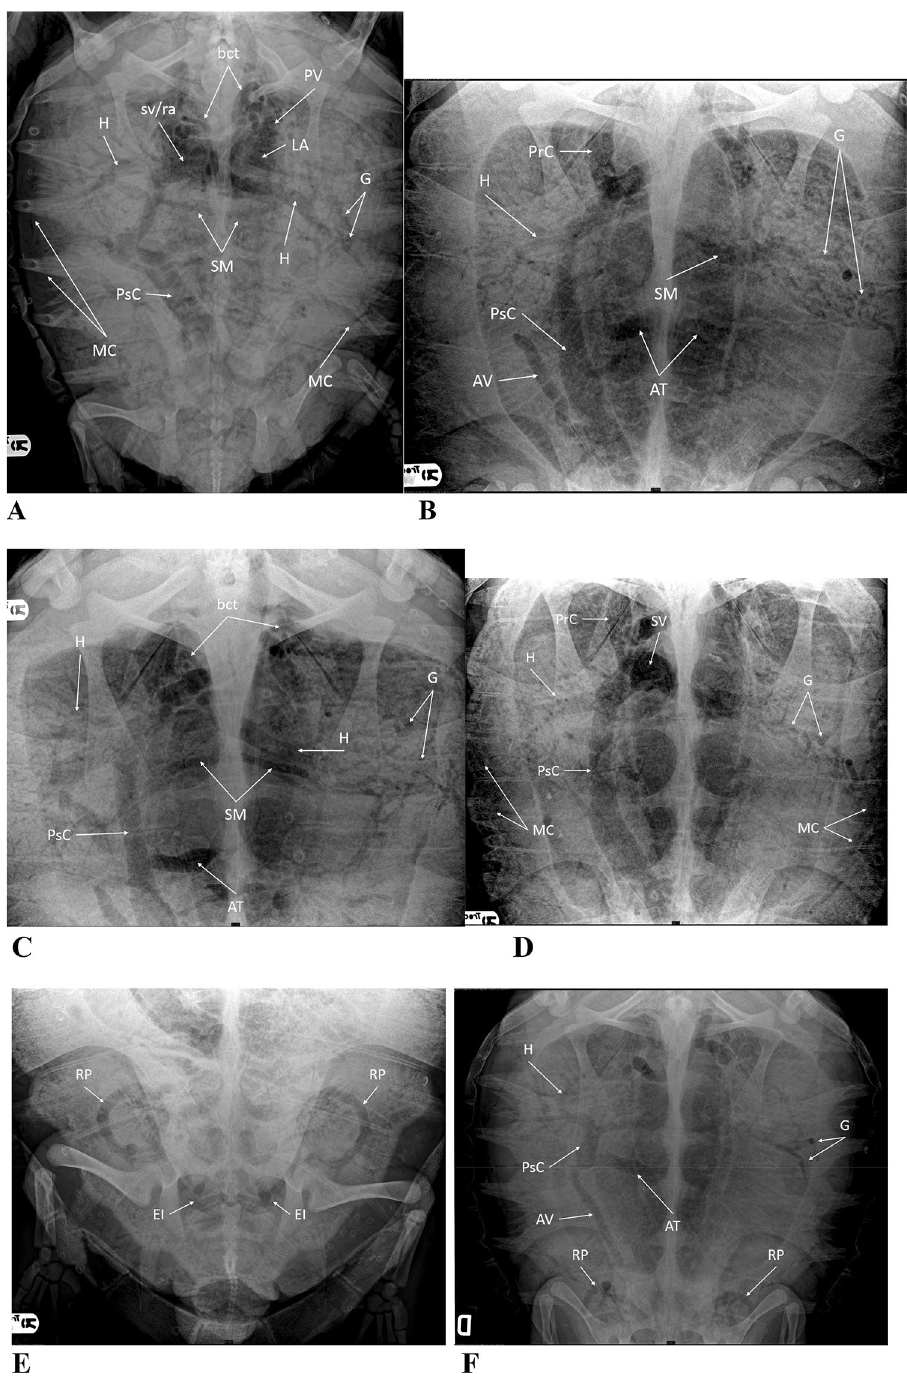
Figure 5. ( A ) Dorsoventral radiograph of a Loggerhead turtle ( Caretta caretta ) with severe GE. Gas is evident in the sinus venosus/right atrium (sv/ra), left atrium (LA), pulmonary vessels (PV), vessels of the brachiocephalic trunk (bct), hepatic vessels (H), gastric vessels (G), postcava vein (PsC), superior mesenteric artery (SM) and marginocostal vessels (MC); ( B,C ) dorsoventral radiograph of two Loggerhead turtles ( Caretta caretta ) with GE of medium to severe degree. Precava (PrC) and postcava vein (PsC), vessels of the brachiocephalic trunk (bct), hepatic vessels (H), gastric vessels (G), superior mesenteric artery (SM), abdominal vein (AV) and transverse abdominal vein (AT); ( D ) dorsoventral radiograph of a Loggerhead turtle ( Caretta caretta ) with severe GE. Gas fills the sinus venosus (SV), left atrium (LA), precava (PrC) and postcava vein (PsC), hepatic vessels (H), gastric vessels (G) and marginocostal vessels (MC); ( E ) dorsoventral radiograph of a Loggerhead turtle ( Caretta caretta ) with GE of mild degree. Gas is present in renal portal vessels (RP) and external iliac vessels (EI); ( F ) dorsoventral radiograph of a Loggerhead turtle ( Caretta caretta ) with GE of medium degree. Gas is present in postcava vein (PsC), hepatic vessels (H), gastric vessels (G), abdominal vein (AV), transverse abdominal vein (AT) and renal portal vessels